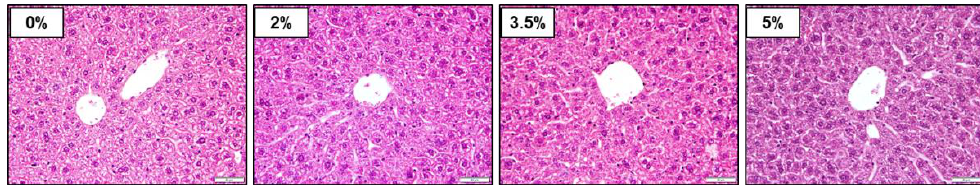
Figure 4. Histopathological changes in the liver of the DSS-induced colitis model. Liver tissues were stained with H&E (400 × magnification).